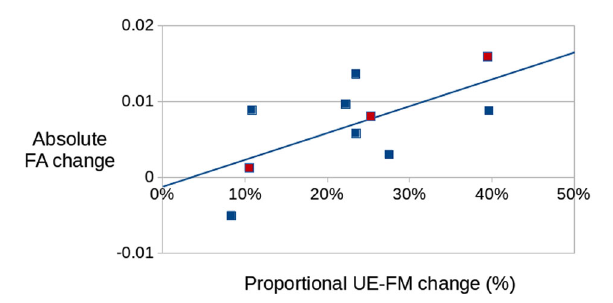
FIGURE 5 | Correlation between changes in FA (obtained from the aMF on the lesional hemisphere) and proportional changes in UE-FM in the treated group ( r = 0.65; p < 0.05) . Red dots are those from the diffusion tensor imaging (DTI) scan that used 30 directions. No differences were seen between the DTI sequences that used 25 directions and the one that used 30